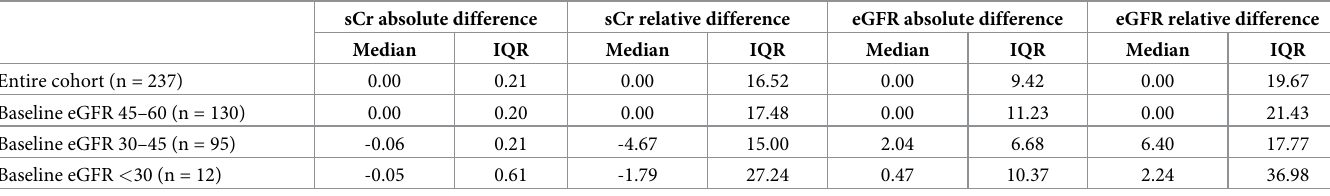
Table 3. Absolute and relative difference in serum creatinine and eGFR between baseline and follow-up for entire cohort and baseline eGFR subgroups. sCr absolute